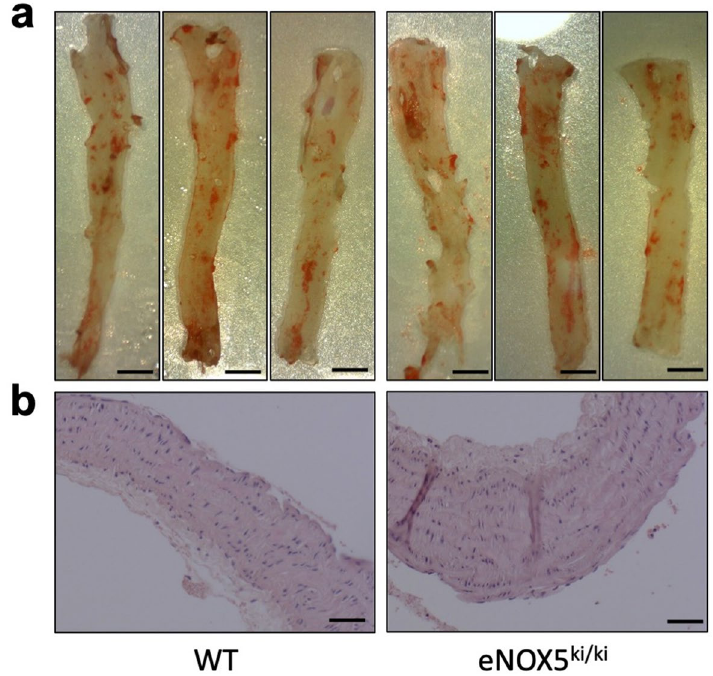
Figure 1. No plaques or fat infiltration in the aorta of the aged eNOX5 ki/ki mice. Representative images of aorta of aged WT and eNOX5 ki/ki mice stained with Sudan stain ( a ) and aortic arch stained with H/E stain ( b ). a. Absence of plaques or fat infiltration in the aorta of the aged WT and eNOX5 ki/ki . b. No fatty streaks or plaque formation were seen in the aortic arch of the aged WT and eNOX5 ki/ki . Plates are representative of n = 4–5 experiments. Bar indicates 2 mm ( a ) and 50 µm ( b ).